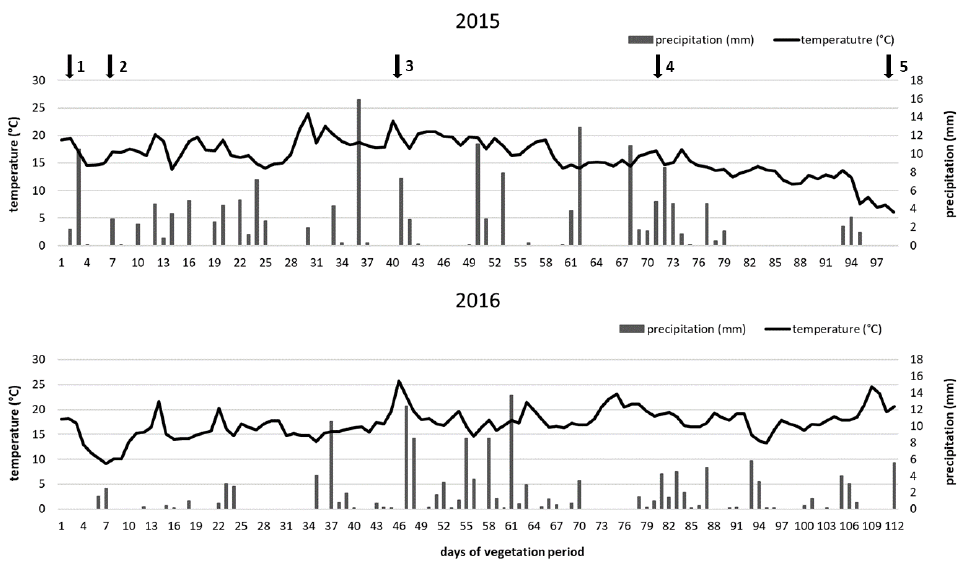
Figure 1. Daily temperature (°C) and precipitation (mm) during the pot experiments (6 kg of a P deficient loamy sand per pot) under semi field conditions in 2015 and 2016. (Arrow 1: sowing, 2: weed germination, 3: 1st sampling, 4: 2nd sampling, 5: 3rd sampling).